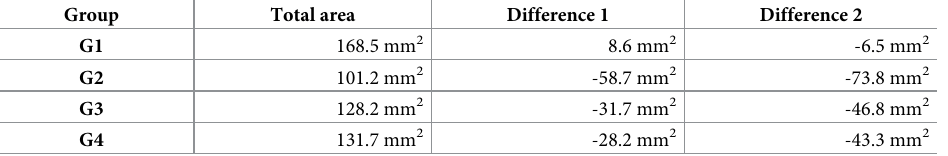
Difference 1 = total area of the instrument–total area of the implant body; difference 2 = total area of the instrument– total area of the implant with the